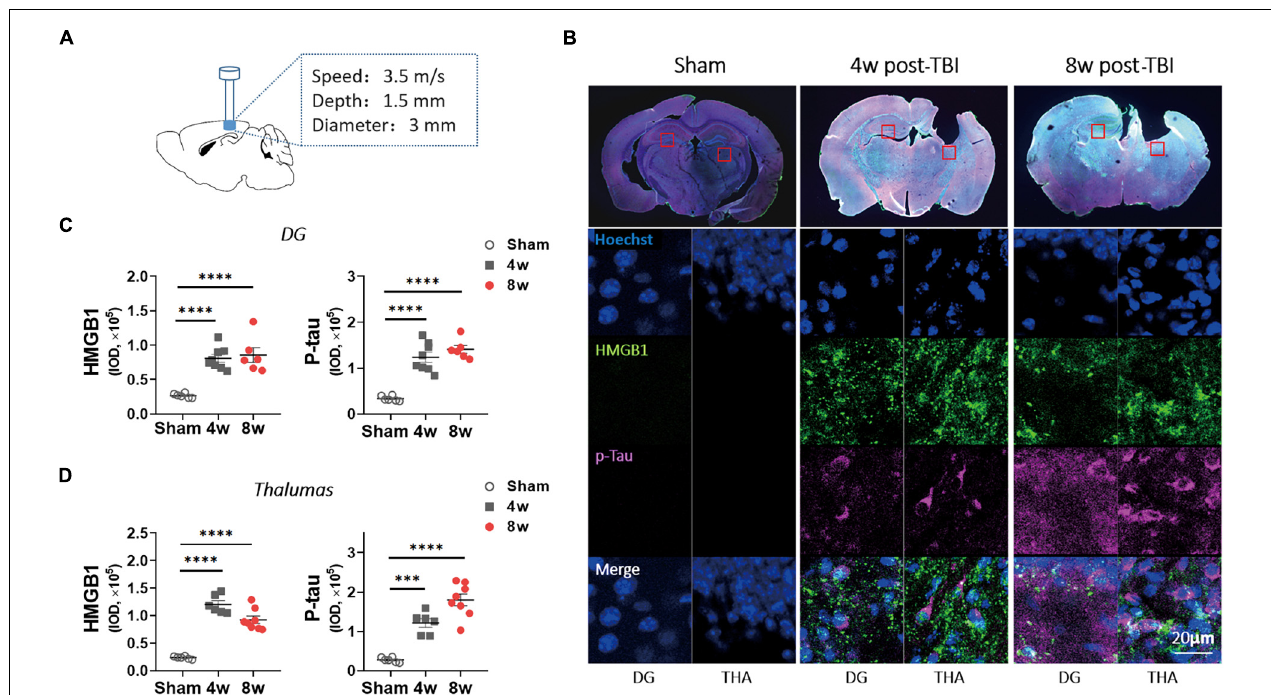
FIGURE 1 | Levels of p-tau and high mobility group box-1 (HMGB1) were increased in wild-type (WT) mice with traumatic brain injury (TBI). (A) An experimental mouse model of TBI. (B) Representative images showed the increased immunoreactivities for HMGB1 and p-tau (ser404) in ipsilateral thalamus (THA) (close to lesion location) and contralateral dentate gyrus (DG) at 4 and 8 weeks (w) post-TBI. (C,D) HMGB1 and p-tau immunoreactivities were quantified with fluorescence intensity in (C) DG and (D) thalamus 4 and 8 weeks post TBI. One-way analysis of variance (ANOVA) was performed followed by Dunnett’s multiple comparisons test. ∗∗∗ p < 0.001, ∗∗∗∗ p <